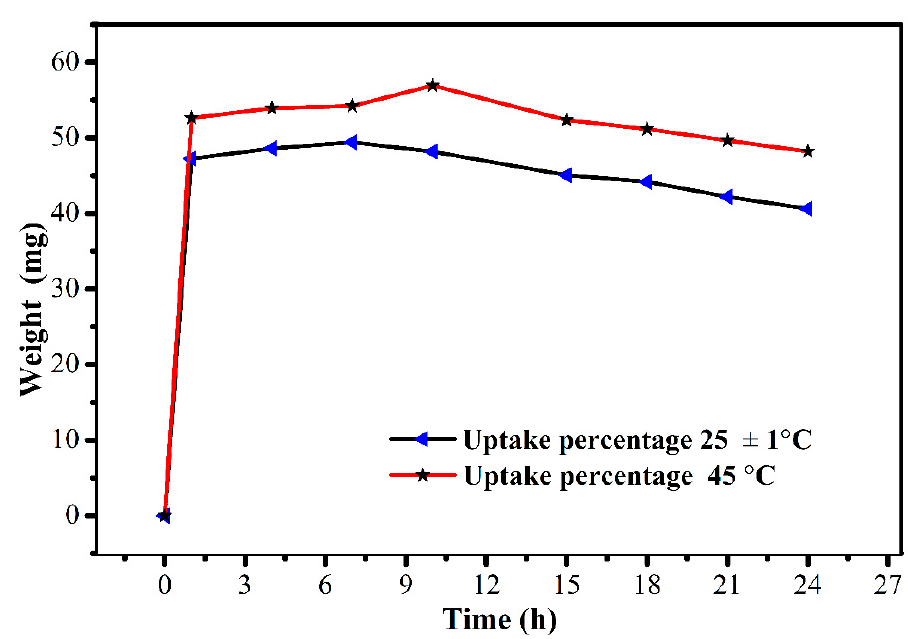
Figure 5. Water loss of the SPVC–PTA–Pt IPMC membrane at 3-6 V DC.